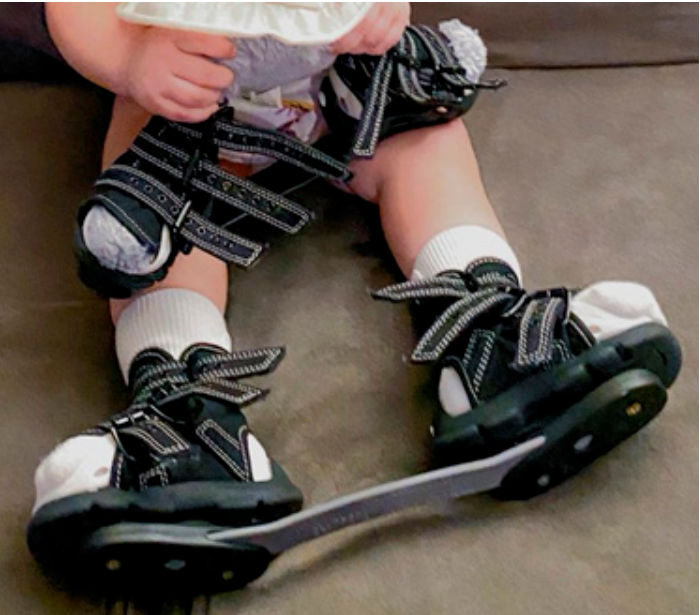
Figure 9. Clinical picture showing a child with fully corrected B/L clubfeet in a correctly designed foot abduction brace.